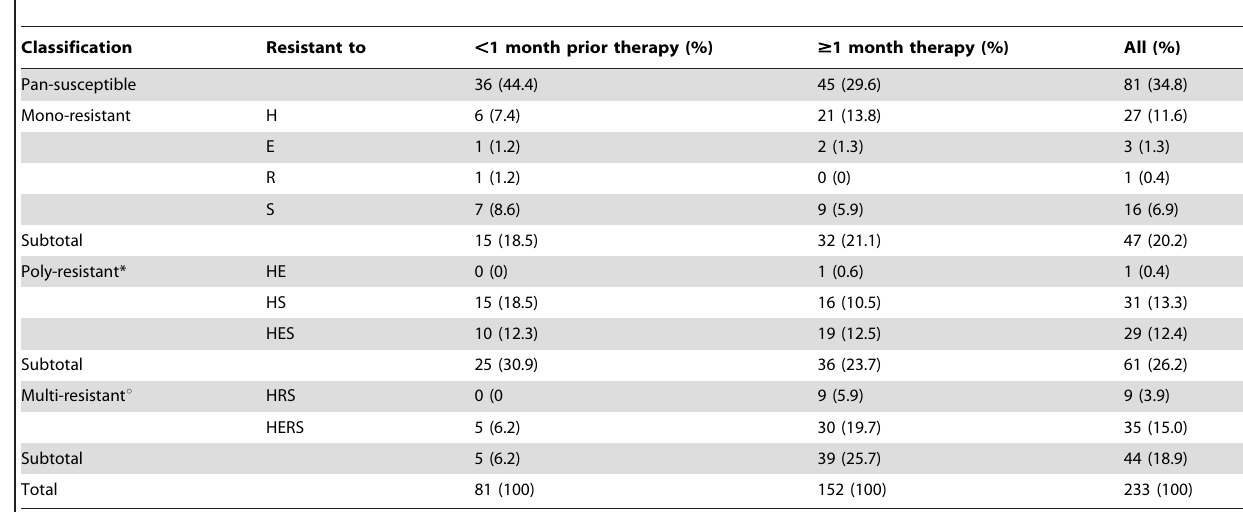
Table 1. Classification of the patients according to drug resistance profiles against the four first-line tuberculosis drugs (H,E,R and S) at time of enrolment (T0).